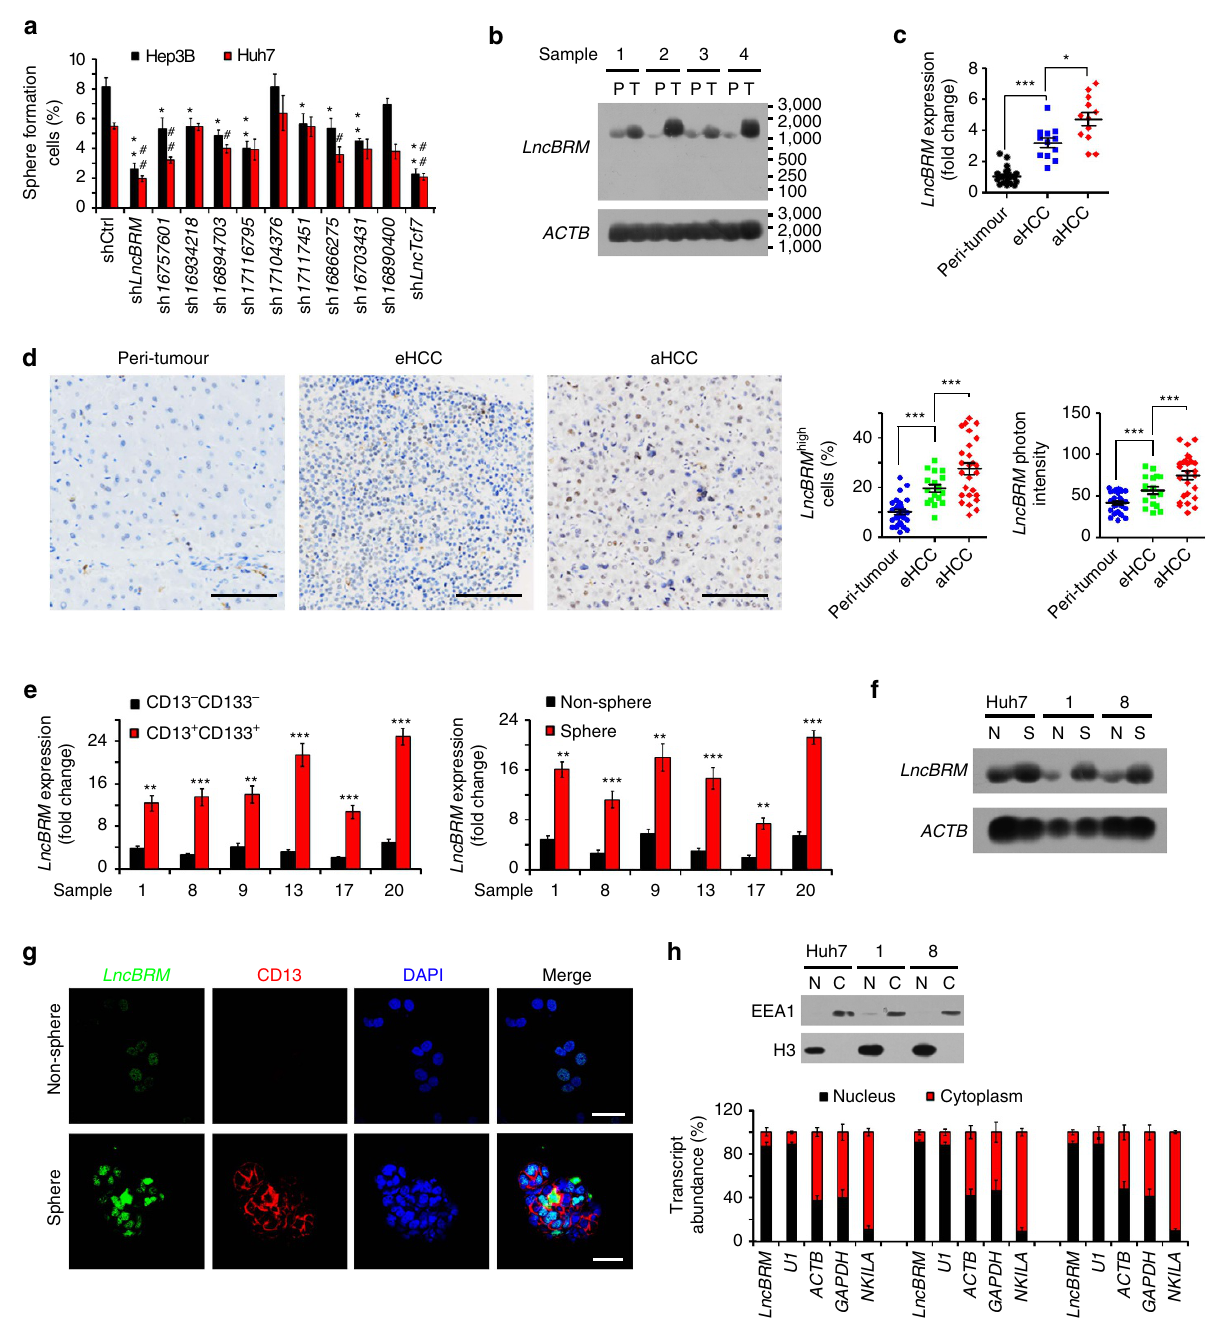
Figure 1 | LncBRM is highly expressed in HCC tumours and liver CSCs. ( a ) The indicated lncRNAs were silenced using pSiCoR lentivirus, followed by sphere formation assays. *, **, for Hep3B cells, Hep3B shlncBRM versus Hep3B shCtrl; #, ##, for Huh7 cells, Huh7 shlncBRM versus Huh7 shCtrl. ( b ) Total RNAs were extracted from peri-tumour (P) and tumour (T) tissues, followed by northern blotting. ACTB served as a loading control. ( c ) Primary HCC samples were prepared for examination of lncBRM expression using RT–qPCR. aHCC, advanced HCC; eHCC, early HCC. ( d ) LncBRM was detected by in situ hybridization. LncBRM highly expressed cells (middle panel) and lncBRM photon intensity (right panel) were calculated by Image-Pro Plus 6 and shown as scatter plot (means ± s.e.m.). Scale bars, 100 m m. ( e ) Liver CSCs (CD13 þ CD133 þ ) and non-CSCs (CD13 (cid:2) CD133 (cid:2) ) were sorted from HCC samples, followed by detection of lncBRM using RT–qPCR (left panel). Oncospheres and non-spheres derived from HCC primary tumour cells were analysed similarly. Expression levels of lncBRM were normalized to that of non-tumour sample 17 as a baseline level. ( f ) lncBRM was examined in oncospheres and non- spheres with northern blotting. N, non-sphere; S, sphere. ( g ) Non-spheres and spheres were stained with lncBRM probes and CD13 antibody for confocal microscopy. Scale bars, 20 m m. ( h ) Nucleocytoplasmic fractionation of oncosphere cells was performed and followed by immunoblotting (upper panel) and RT–qPCR (lower panel). U1 RNA served as a nuclear location control and NKILA was used as a cytoplasmic location control. Data are shown as means ± s.d. Two tailed Student’s t -test was used for statistical analysis; * P o 0.05, ** P o 0.01, *** P o 0.001; # P o 0.05, ## P o 0.01. Data are representative of at least three independent